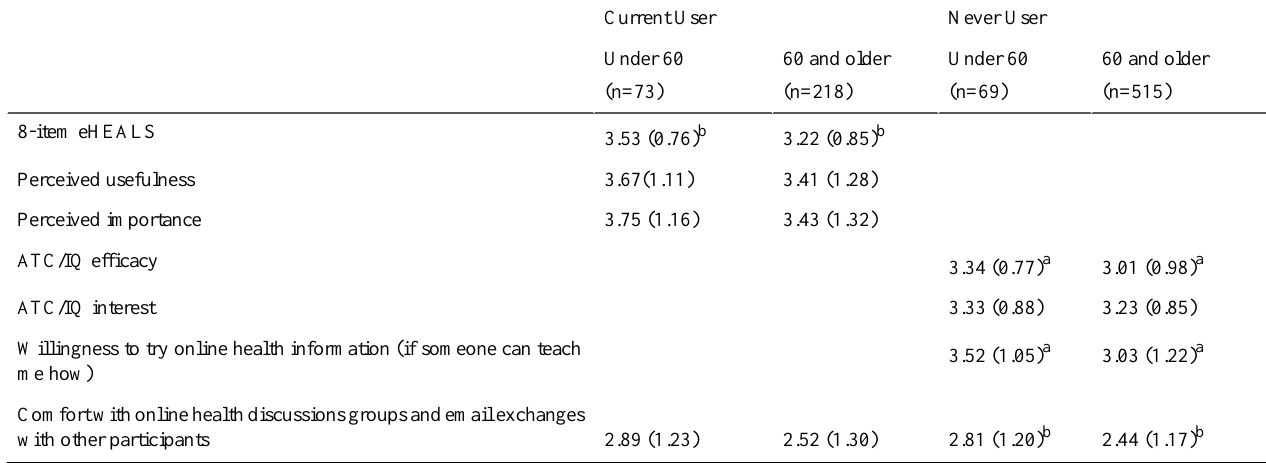
Table 5. eHealth Literacy (eHEALS), Attitudes Toward Computer/Internet (ATC/IQ), and willingness to use health information searches and online health discussion groups: mean and standard deviation of the